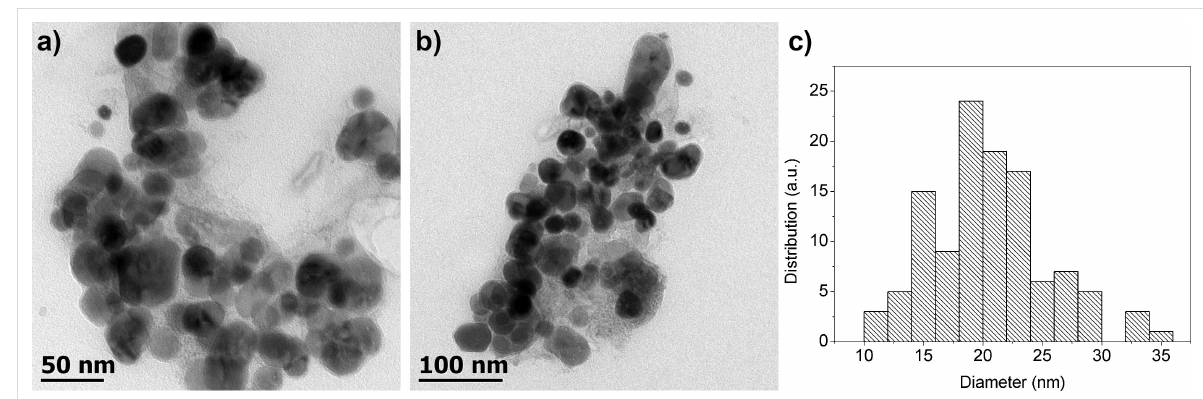
Figure 2: a) and b) TEM images of the FeS 2 NCs at the 50 and 100 nm scale and c) size distribution of the